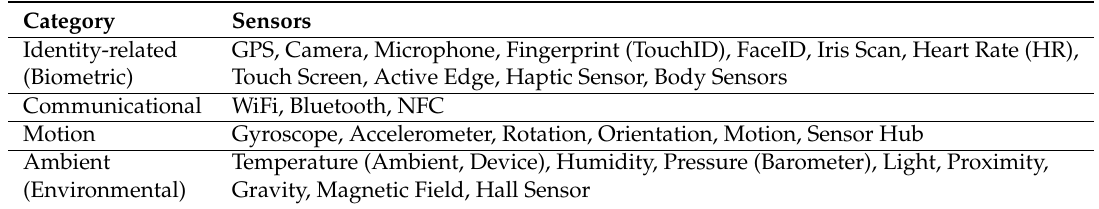
Table 1. Categorization of current mobile